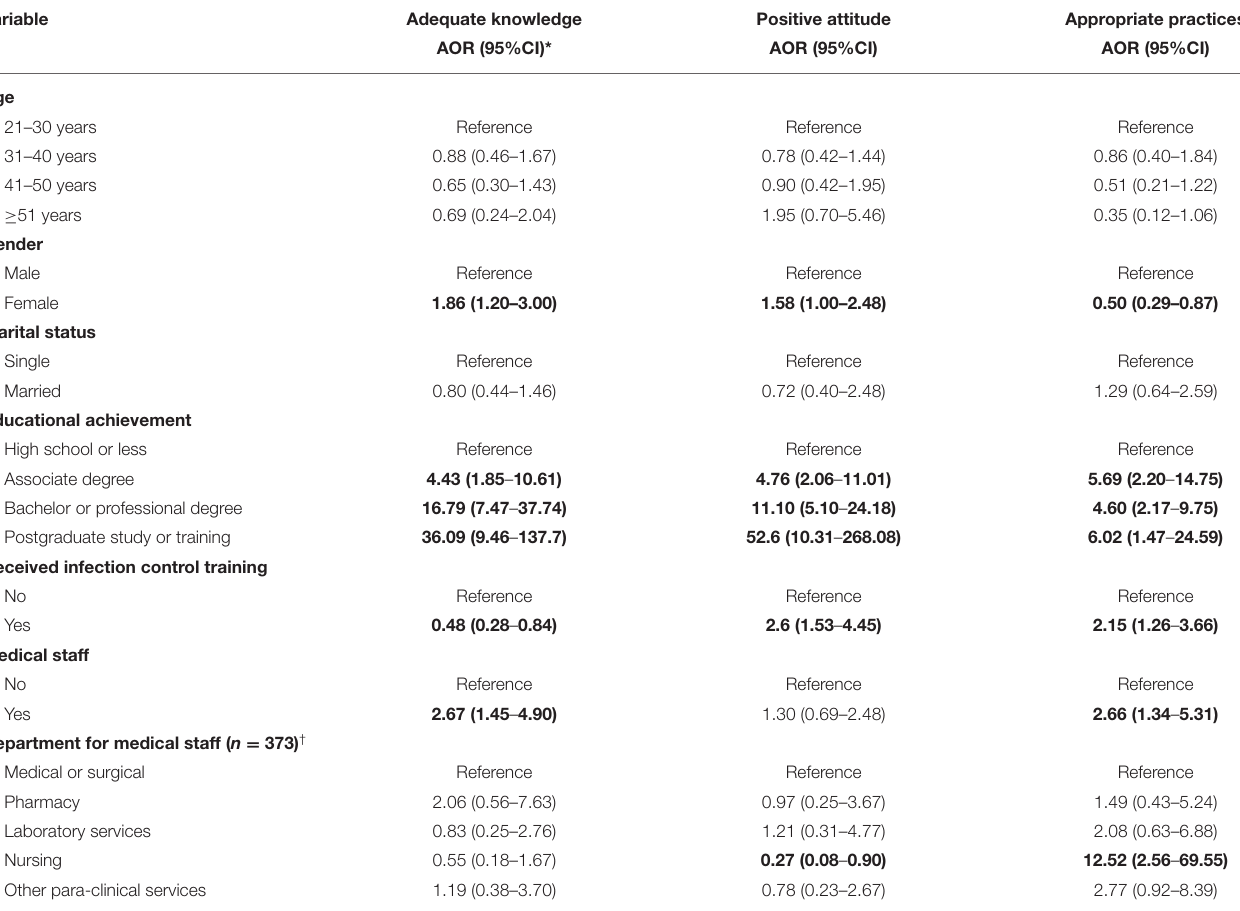
TABLE 7 | Multivariable logistic regression for the adequate knowledge, positive attitude, and appropriate practices based on the demographics and characteristics of the participants.